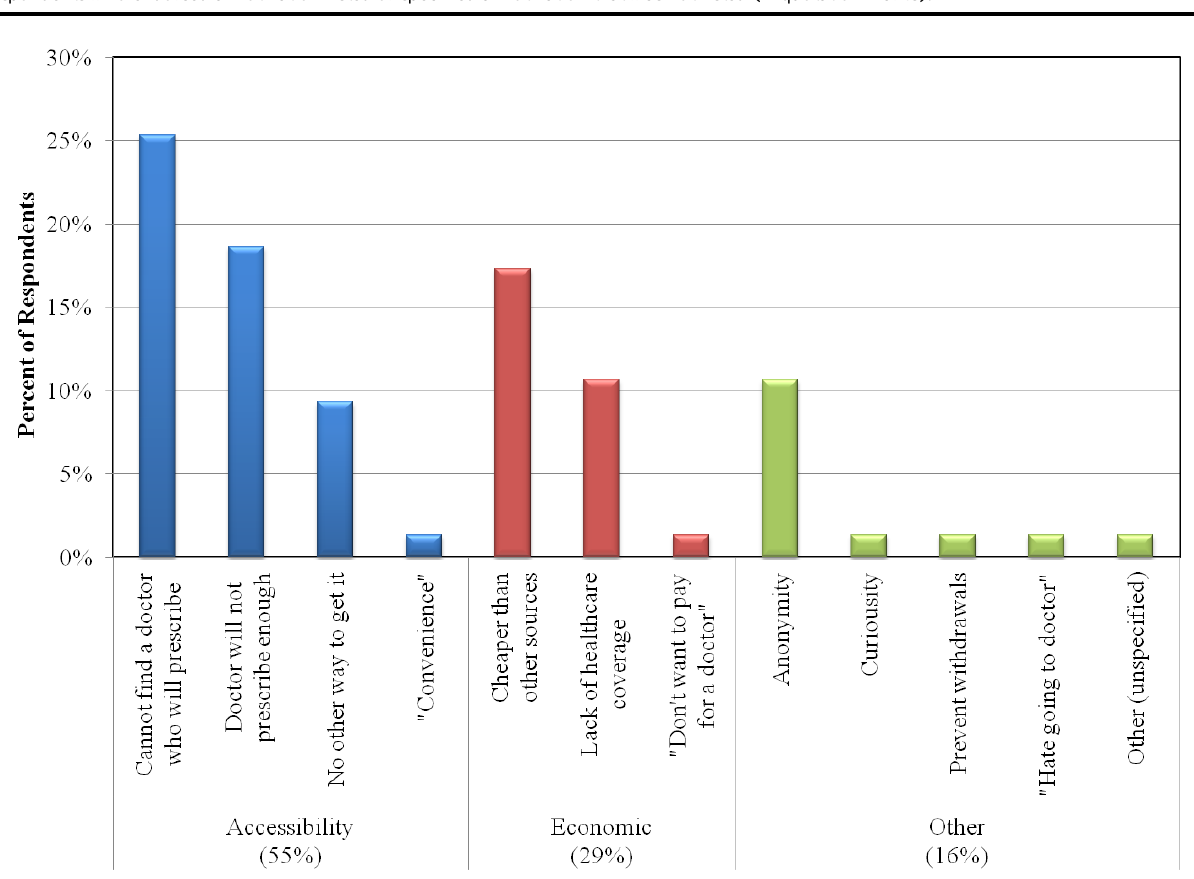
Figure 1. Motivations for using online pharmacies as a source of tramadol reported by nontraditional users (N=96). The values given are the percent of respondents who endorsed a motivation listed or specified a motivation that was not listed (in quotation